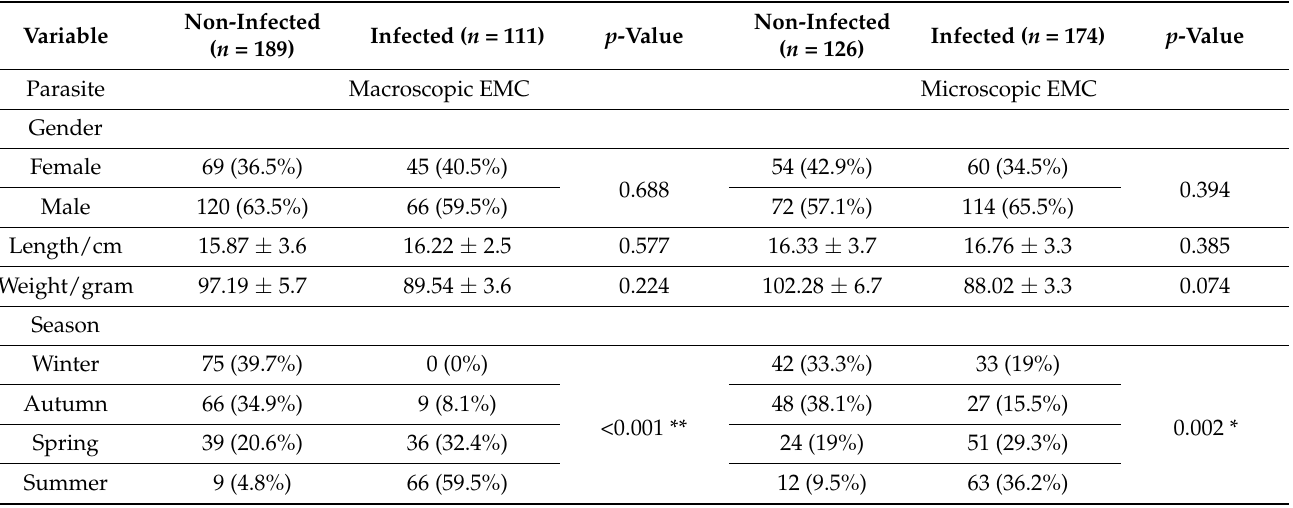
Table 5. Prevalence of macroscopic and microscopic encysted metacercariae in relation to sex, size and seasonal condition.